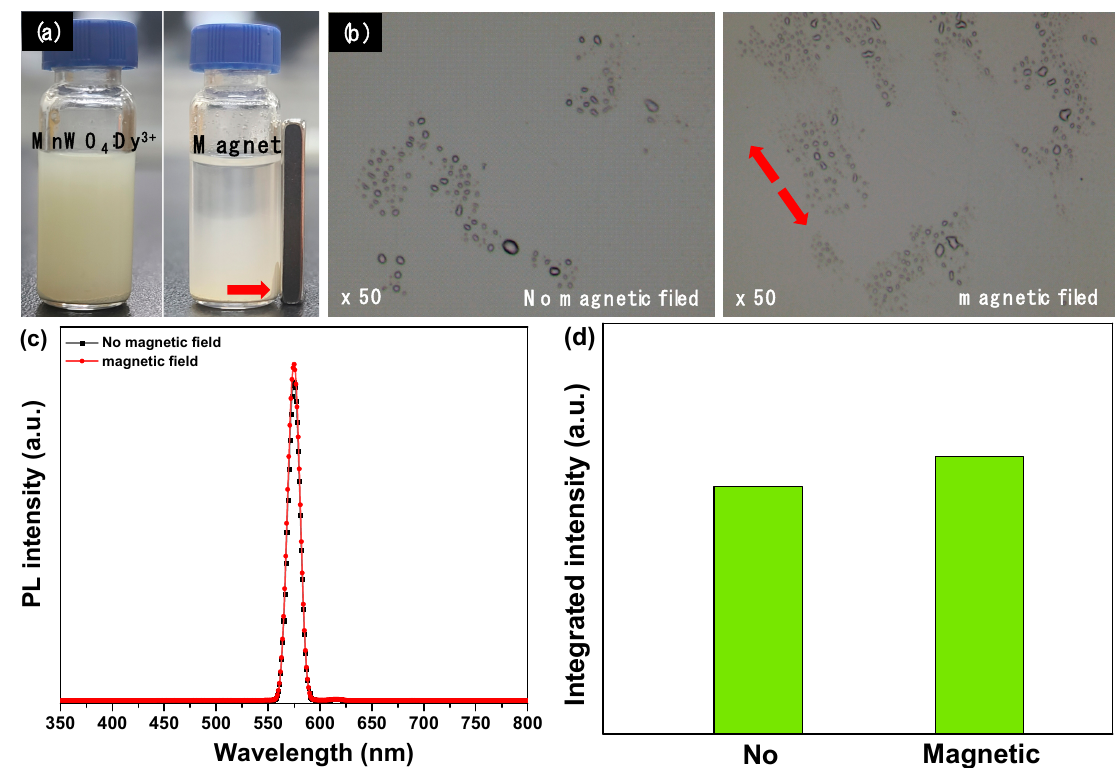
Figure 8. ( a ) Photograph of MnWO 4 :Dy 3+ powder moved to magnet in ethanol, ( b ) OM images of MnWO 4 :Dy 3+ particle behavior with magnetic field, ( c ) PL spectra, and ( d ) integrated PL intensity with magnetic field.